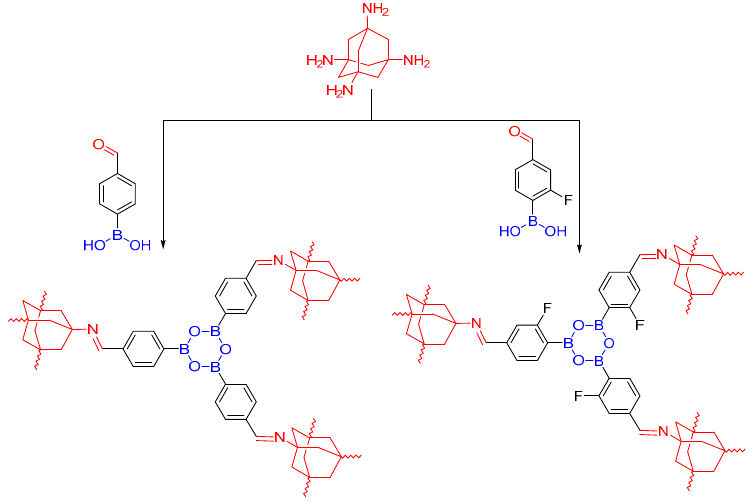
Figure 26. Syntheses 3D COFs of (i) DL-COF-1 and (ii) DL-COF-2 by two types of covalent bonds from orthogonal reactions.